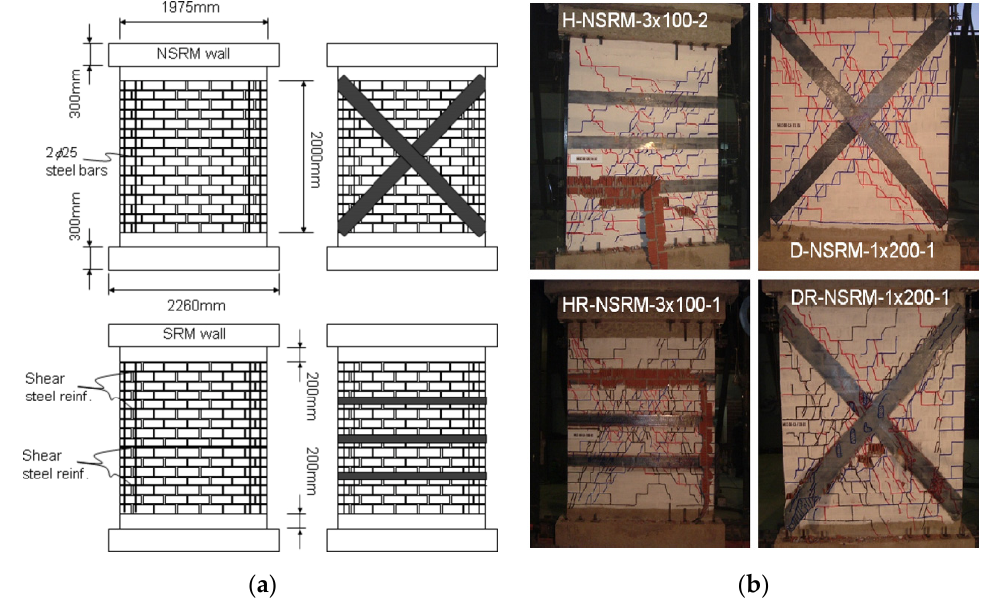
Figure 6. CFRP reinforcement URM walls tests [30]: ( a ) Overall dimensions of the walls and configurations of the CFRP reinforcement, ( b ) Cracking pattern and failure modes of repaired and strengthened URM walls. Reproduced with permission from Santa-Maria, H., Alcaino, P. Repair of in-plane shear damaged masonry walls with external FRP; published by Elsevier, Construction and Building Materials,